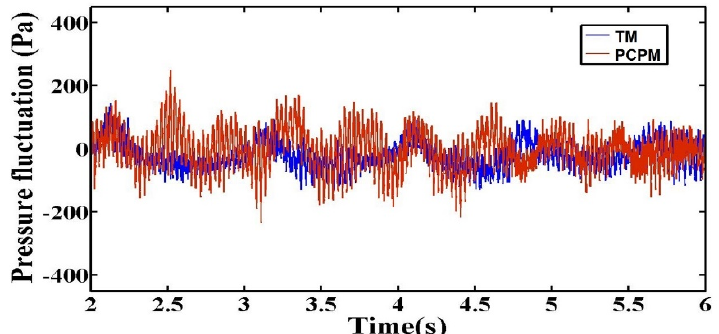
Figure 11. Pressure drop at the 45 mm horizontal section above the fluidized bed distributor simulated with a coarse grain ratio 2 l = .